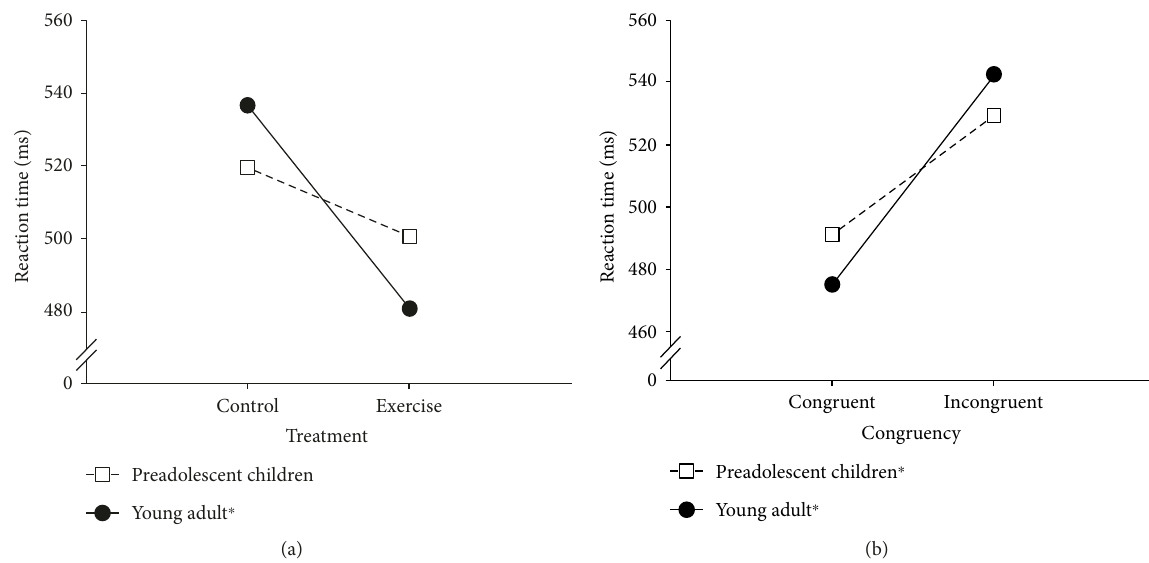
Figure 1: (a) Interaction e ff ect of treatment and group. (b) Interaction e ff ects of condition and group. ∗ Signi fi cant di ff erence ( p < 0 05